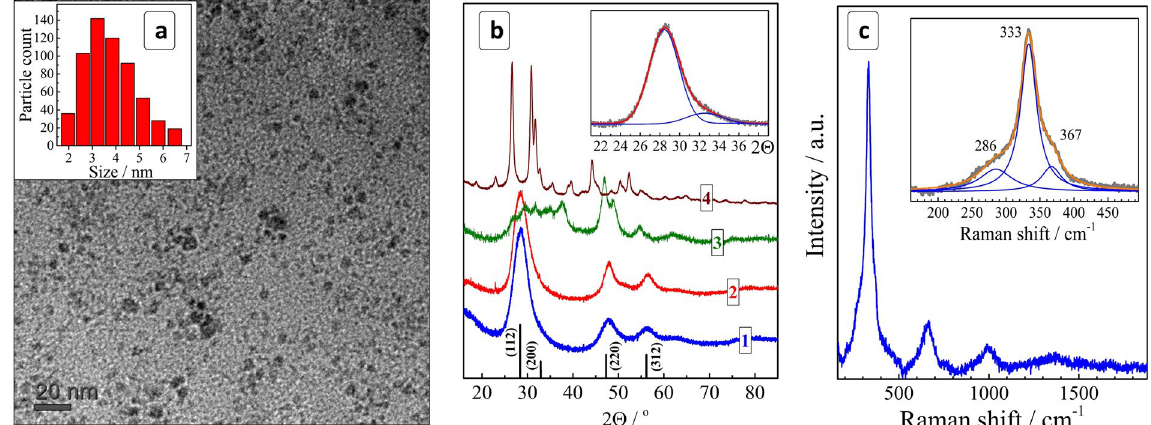
Figure 1. ( a ) TEM image and size distribution of CZTS NCs. ( b ) X-ray diffractograms of CZTS NCs (curve 1) as well as Cu-Sn-S (2), Cu-S (3), and Sn-S (4) samples produced under the same conditions. Black vertical lines show the positions of bulk kesterite diffraction peaks with corresponding face indices (JCPDS No. 26-0575). Inset: fitting of the (112/200) peak range with two Gauss profiles. ( c ) Raman spectrum of unfractionated CZTS NCs. Insert: fitting of a section of the first-order phonon range with a set of three Lorentz